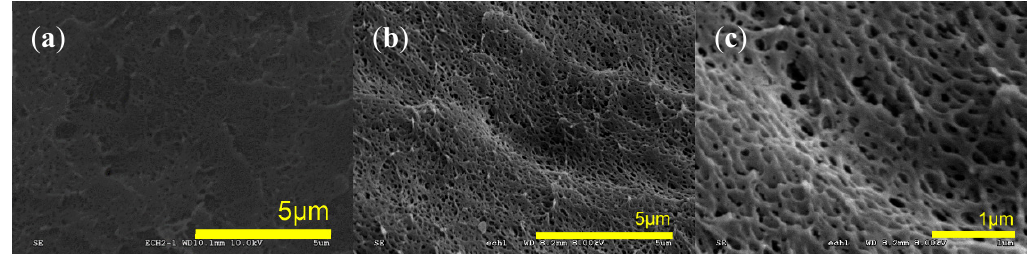
Figure 5. Set II PMMA/20 wt% MAM ice immersed after batch foaming at 10 MPa and 30 °C, ( a ) area of the sample where a transition transparent to translucent is observed, that is a “nonporous to porous” transition (reminder: Sample is thick), ( b , c ) area of the sample where opacity (even slight) is observed, that is a porous region (reminder: Sample is thick).